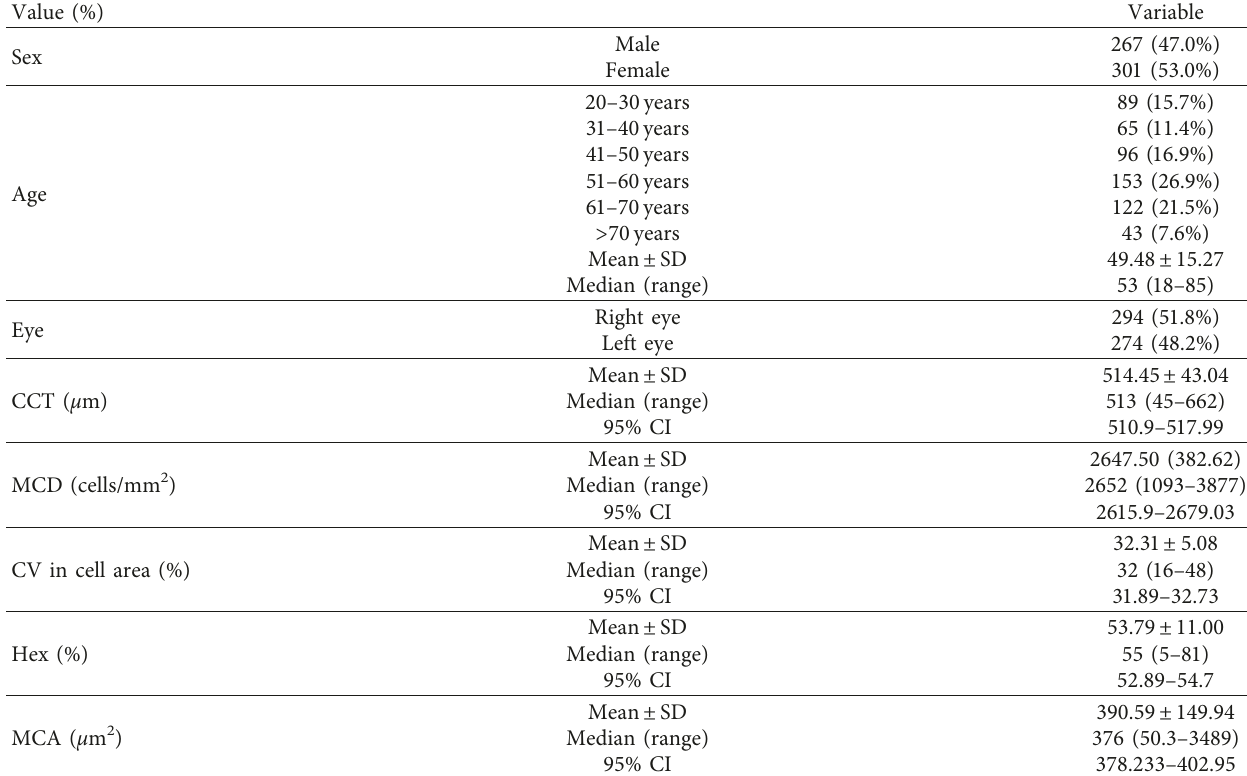
Table 1: Demographic characteristics and variables pertaining to the corneal endothelial cell density and morphology for Egyptian subjects with healthy eyes.